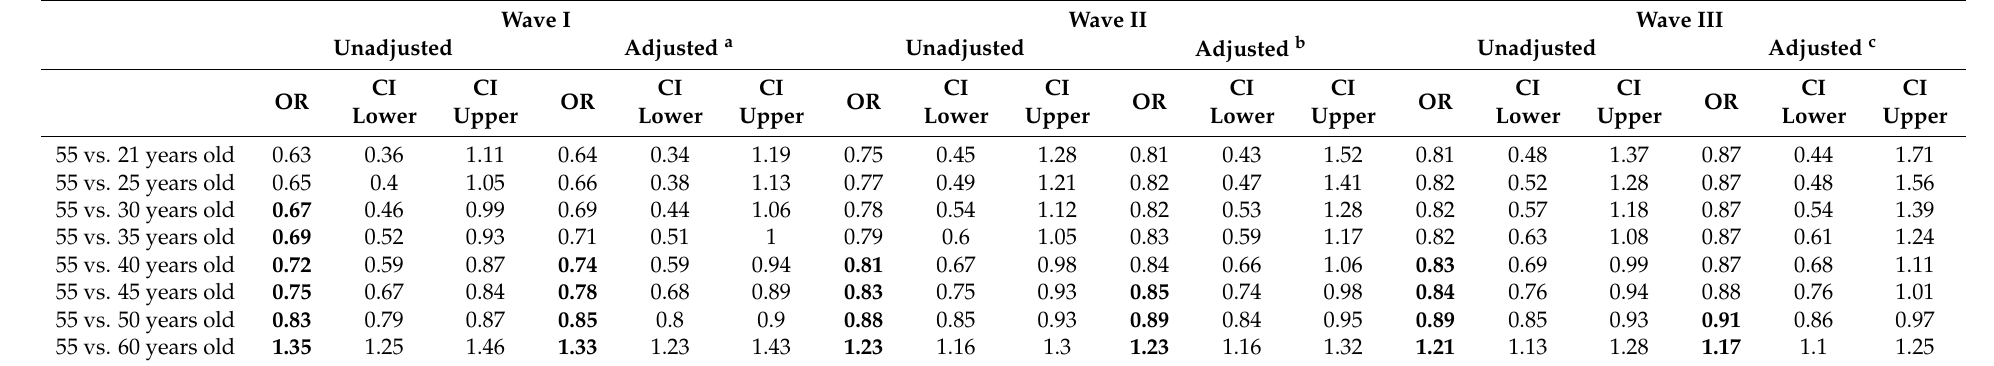
Table 3. Unadjusted and Adjusted Odds Ratios of Increased Alcohol Consumption for 5-year Age Differences in Each